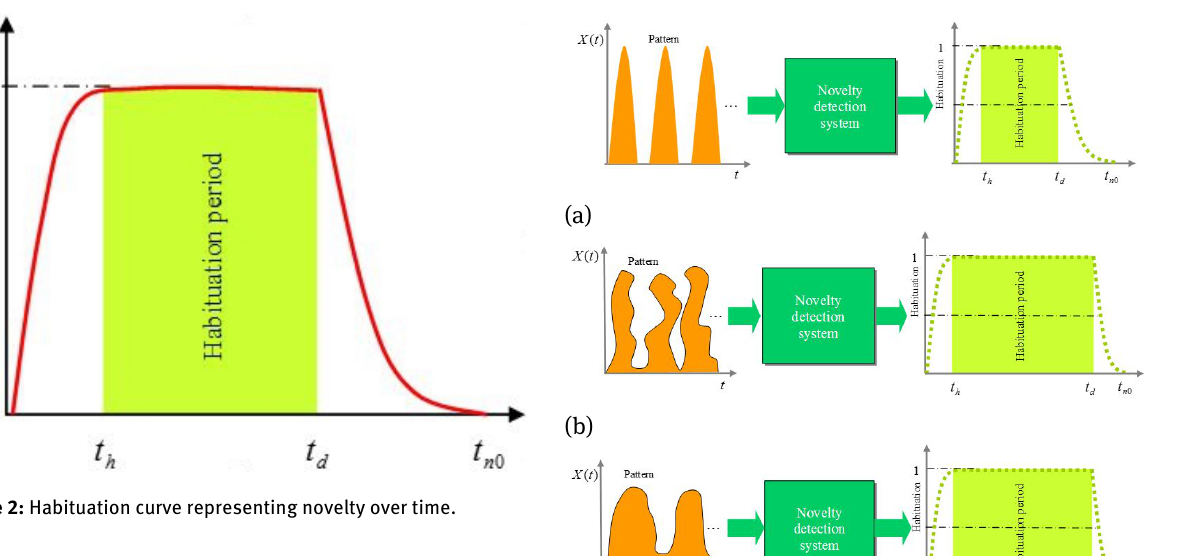
habituation. That means the stimuli or perception has the maximumnovelty.Someexamplesofhabituationfunction characterising the features discussed above are shown in Figure 3. Figure 3: Habituation as a response to patterns of stimuli: (a)